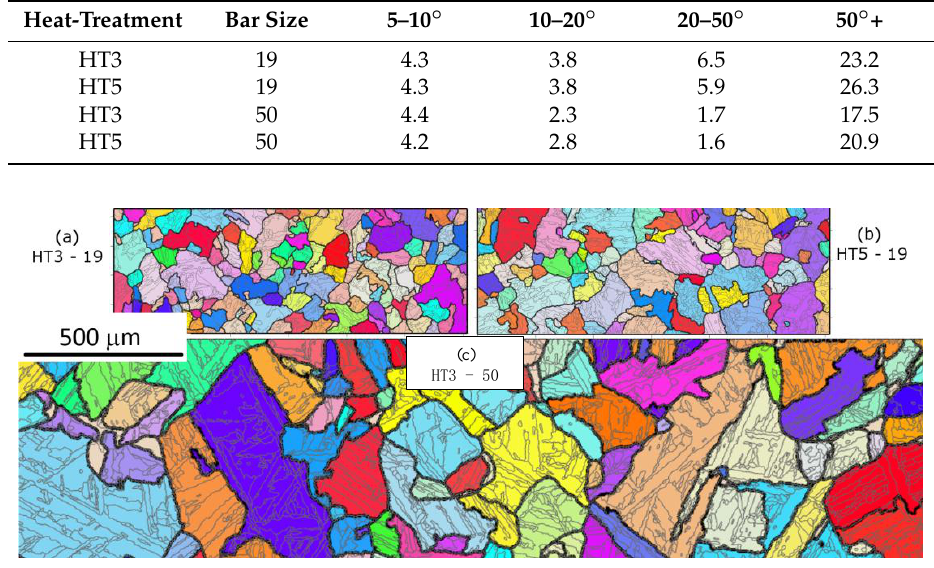
Figure 2. EBSD maps of the different starting microstructures. ( a ) HT3 19 mm bar; ( b ) HT5 19 mm bar; ( c ) HT3 50 mm bar. The maps display boundaries of different types the thick black lines are used to represent probable PAG boundaries (calculated by ARPGE), thinner grey lines represent block boundaries, and are boundaries with misorientations greater than 5°. The colours represent the IPFz orientation of the austenite as calculated by ARPGE. All figures have the same scale, shown on the left.